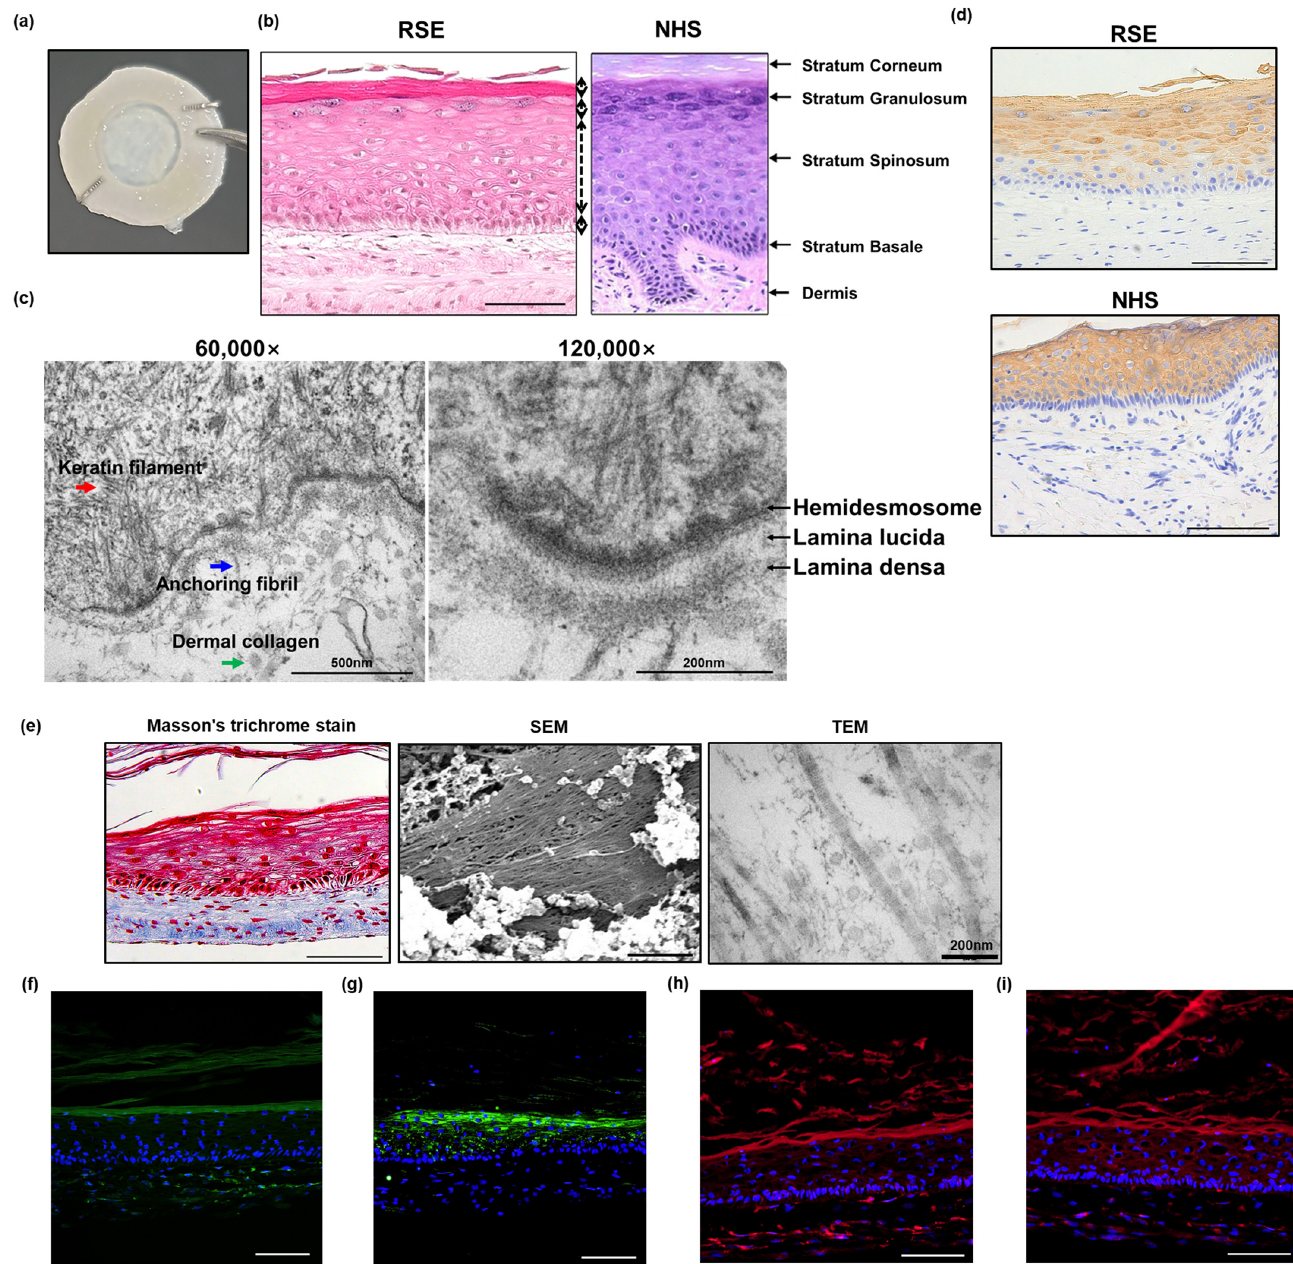
Figure 2. Histological morphology of self-assembled RSE model. ( a ) Macroscopic aspect of the full-thickness skin equivalents produced according to the self-assembly approach of tissue engineering; ( b ) comparison between NHS and fully differentiated self-assembled RSE model by H&E staining (Bar = 100 µm); ( c ) basement membrane structure of the self-assembled RSE model by TEM; ( d ) comparison of KRT10 protein expression between NHS and self-assembled RSE model analyzed by immunohistochemical staining (Bar = 100 µm); ( e ) collagen in the dermis of self-assembled RSE an- alyzed by Masson’s trichrome stain (Left, Bar = 100 µm), SEM (Middle, Bar = 5 µm), and TEM (Right, Bar = 200 µm); ( f – i ) immunofluorescence staining analysis of ( f ) filaggrin, ( g ) involucrin, ( h ) ZO-1, and ( i ) claudin-1 in self-assembled RSE model (Bar = 100 µm, n = 4). NHS: Normal human skin; RSE: Reconstructed skin equivalent.